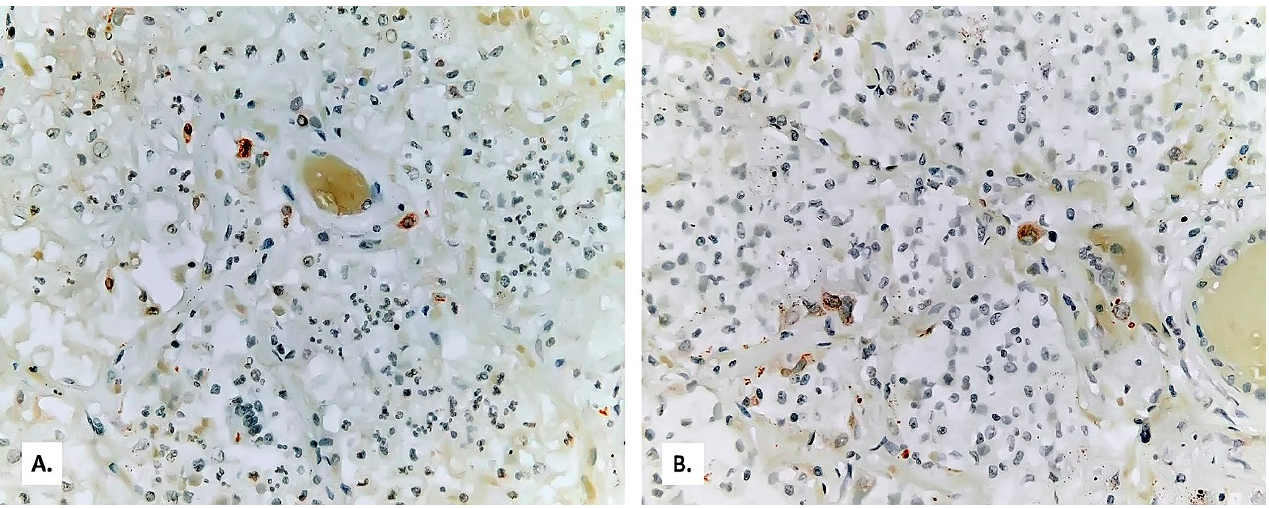
Figure 8. ( A ) Immunolabeling with leukocyte common antigen (CD45) (×40). ( B ) Immunolabeling with CD3 (×200).